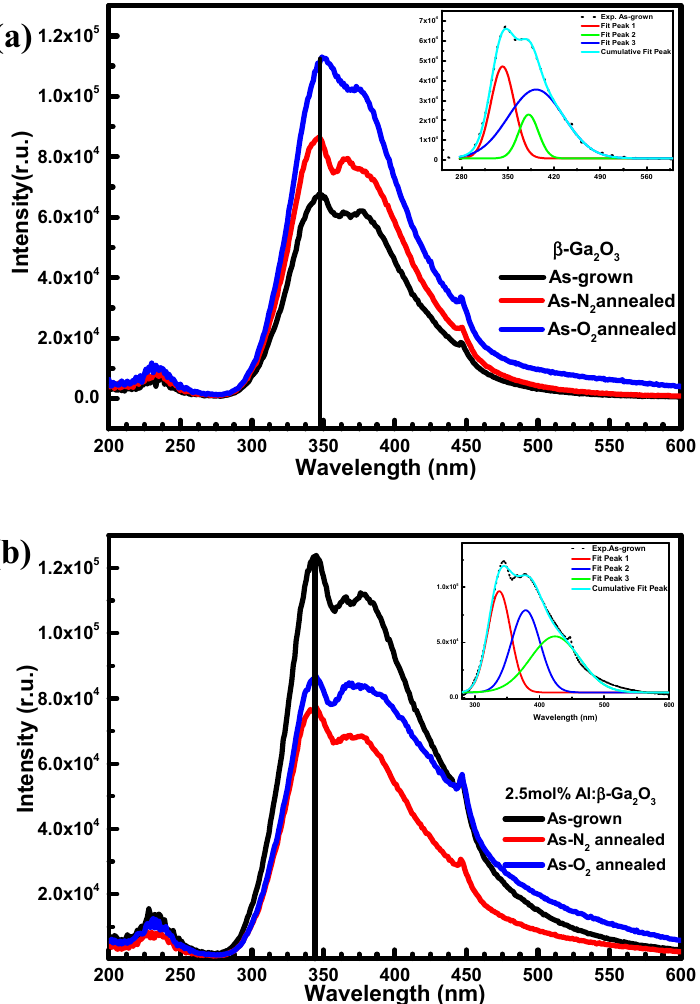
Figure 2. X-ray luminescence spectra of ( a ) pure and ( b ) 2.5 mole% Al-doped β -Ga 2 O 3